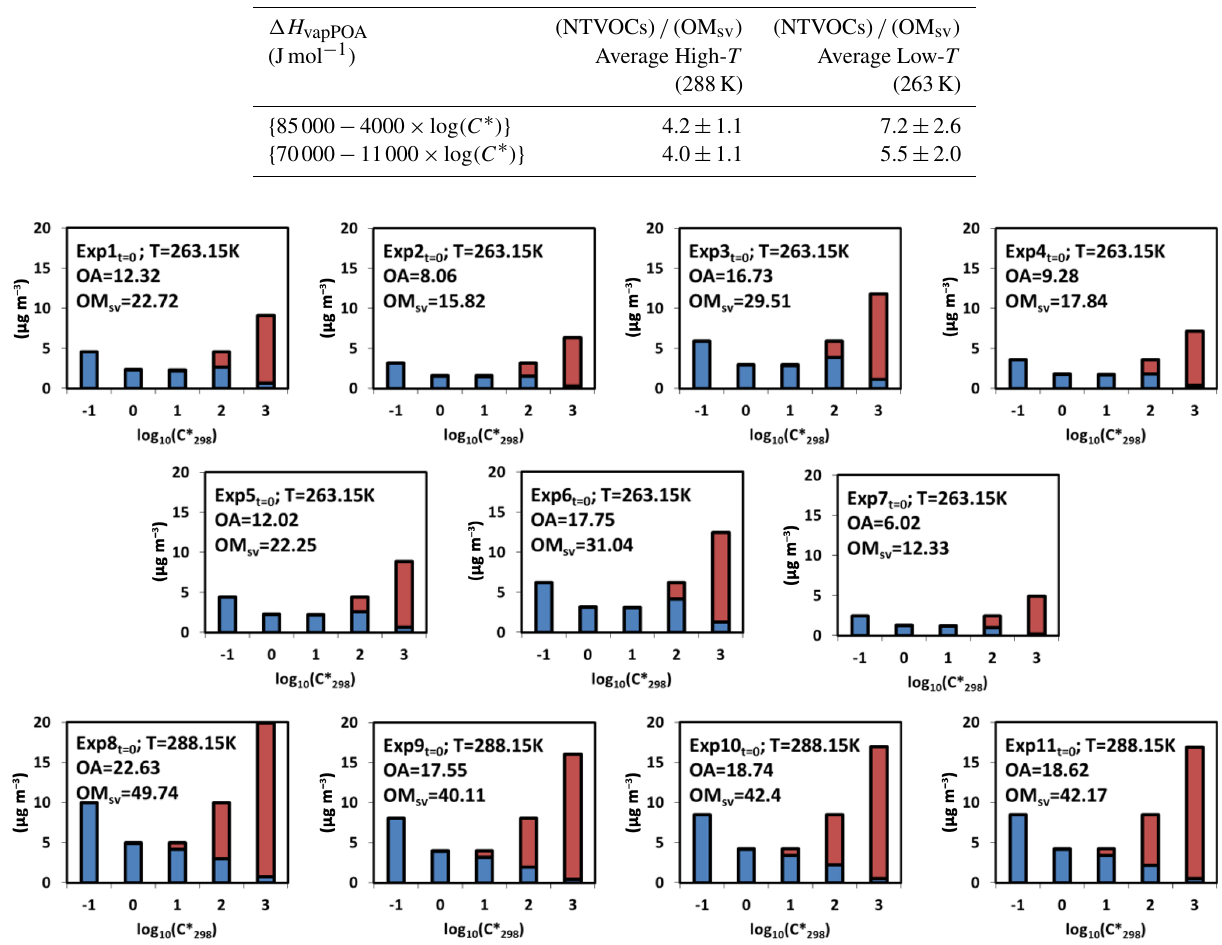
Figure 2. Partitioning of wood-burning POA before the start of the aging for 11 smog chamber experiments (SOL2). Gas phase in red and particle phase in blue.